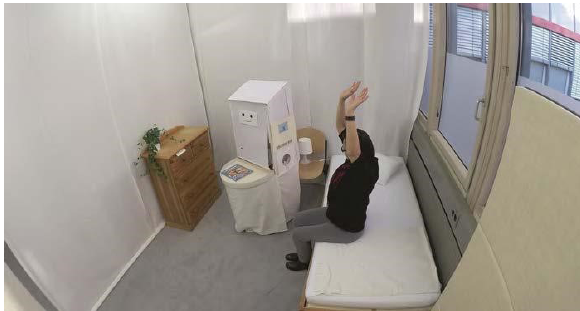
Figure 12: Experimental set up from